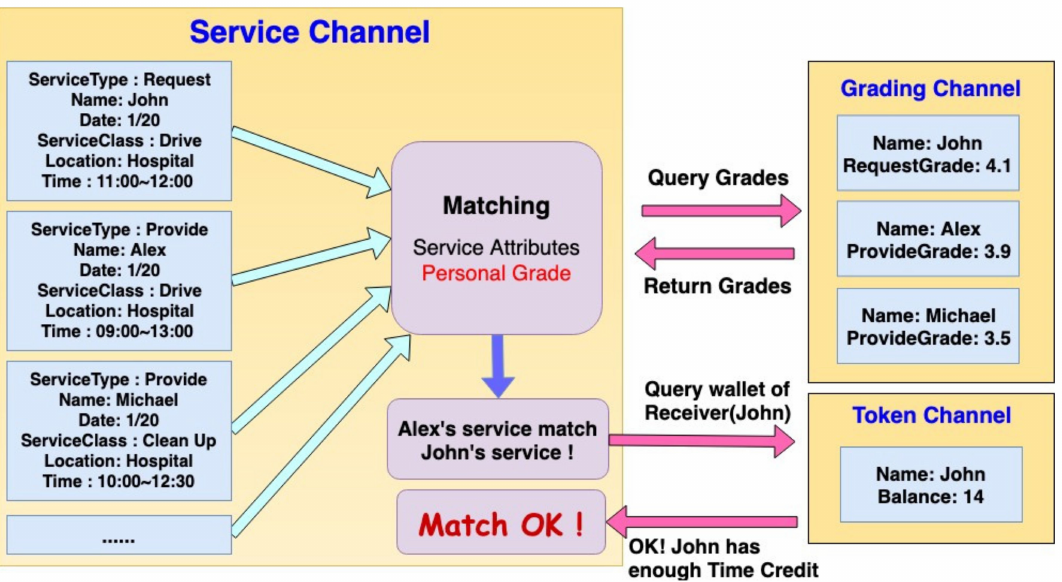
Figure 5. The service-matching process in the service channel